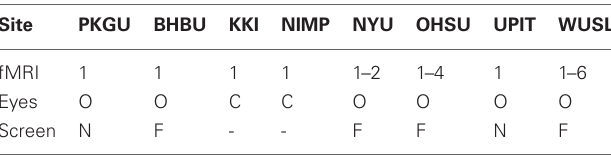
Table 2 | Details on resting state fMRI recordings in the ADHD-200 dataset with respect to the